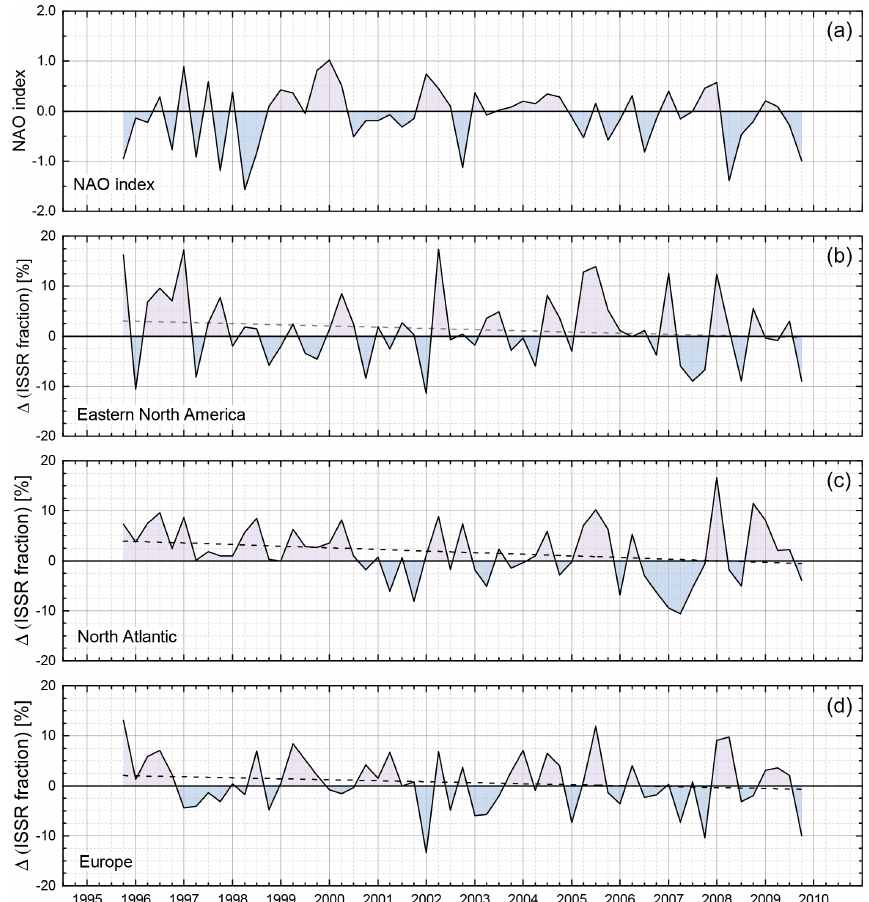
Figure 15. Time series of the North Atlantic Oscillation (NAO) index ( a ) and de-seasonalized time series of ISSR fraction (probability of occurrence) for latitudes of 40 to 60 ◦ N and for the regions of (from b to d ) eastern North America (105 to 65 ◦ W), the North Atlantic (65 to 5 ◦ W) and Europe (5 ◦ W to 30 ◦ E).